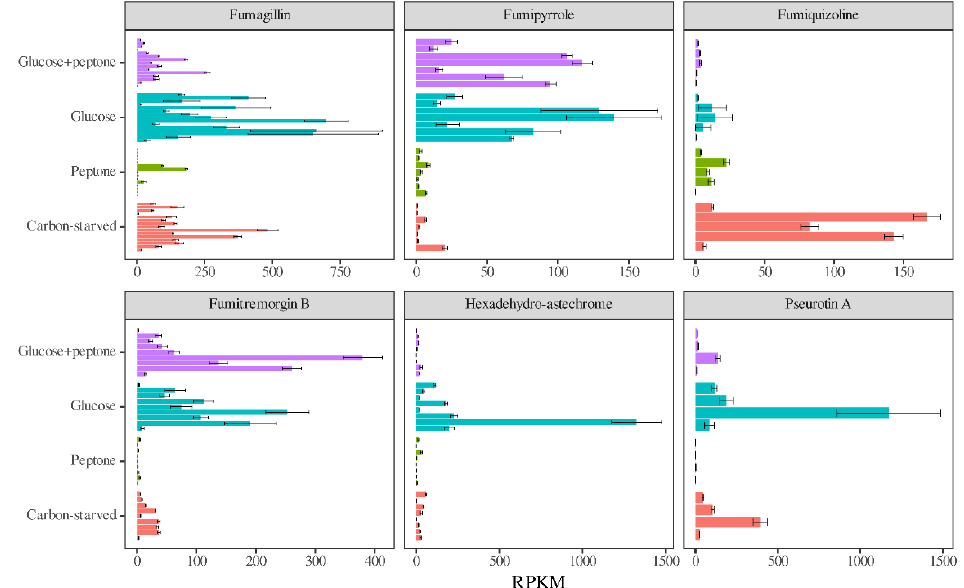
Figure 7. Effects of peptone and glucose withdrawal on the transcriptional activity of genes of selected secondary metabolite clusters in Aspergillus fumigatus Af293. RPKM values generated from the RNAseq experiments (mean ± SD; n = 3) are presented.